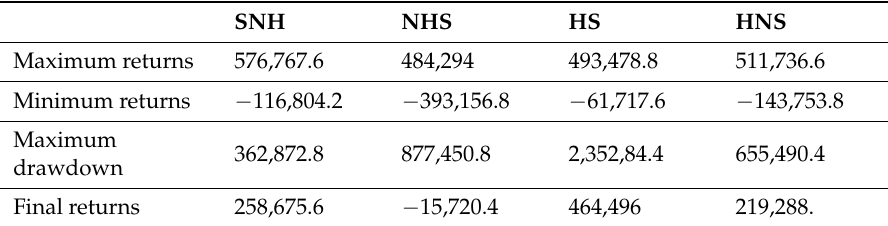
Table 7. Comparison of four strategic